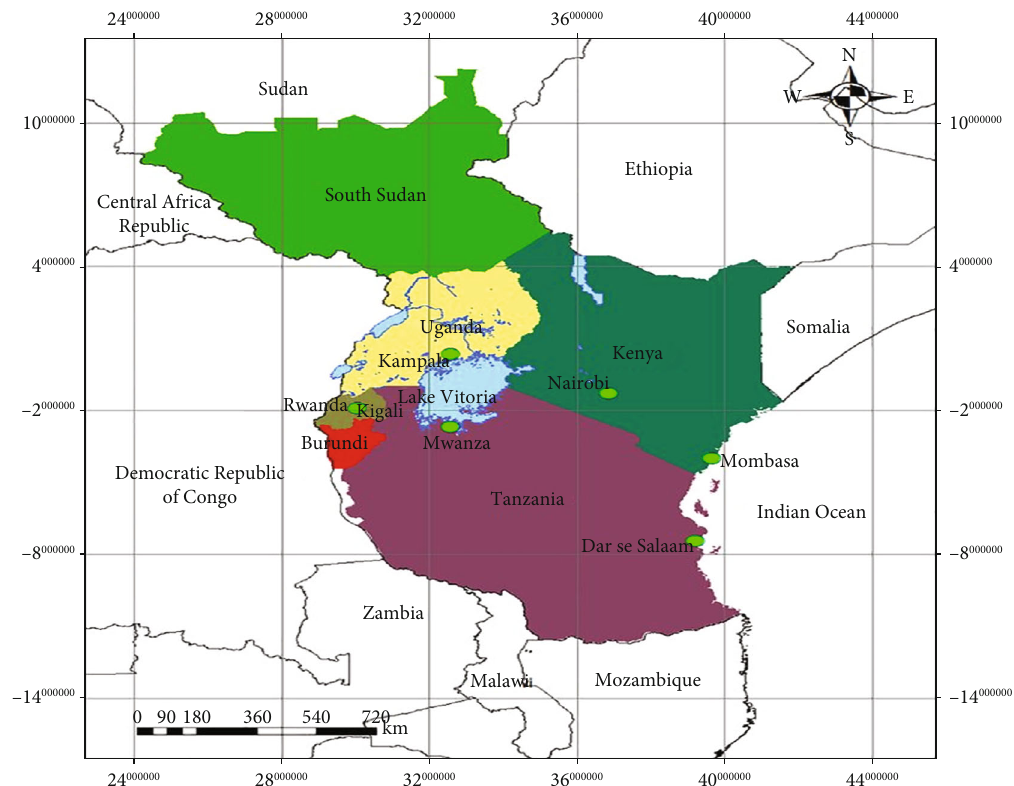
Figure 2: The six East Africa Community countries (Source: Telesphore Kabera).